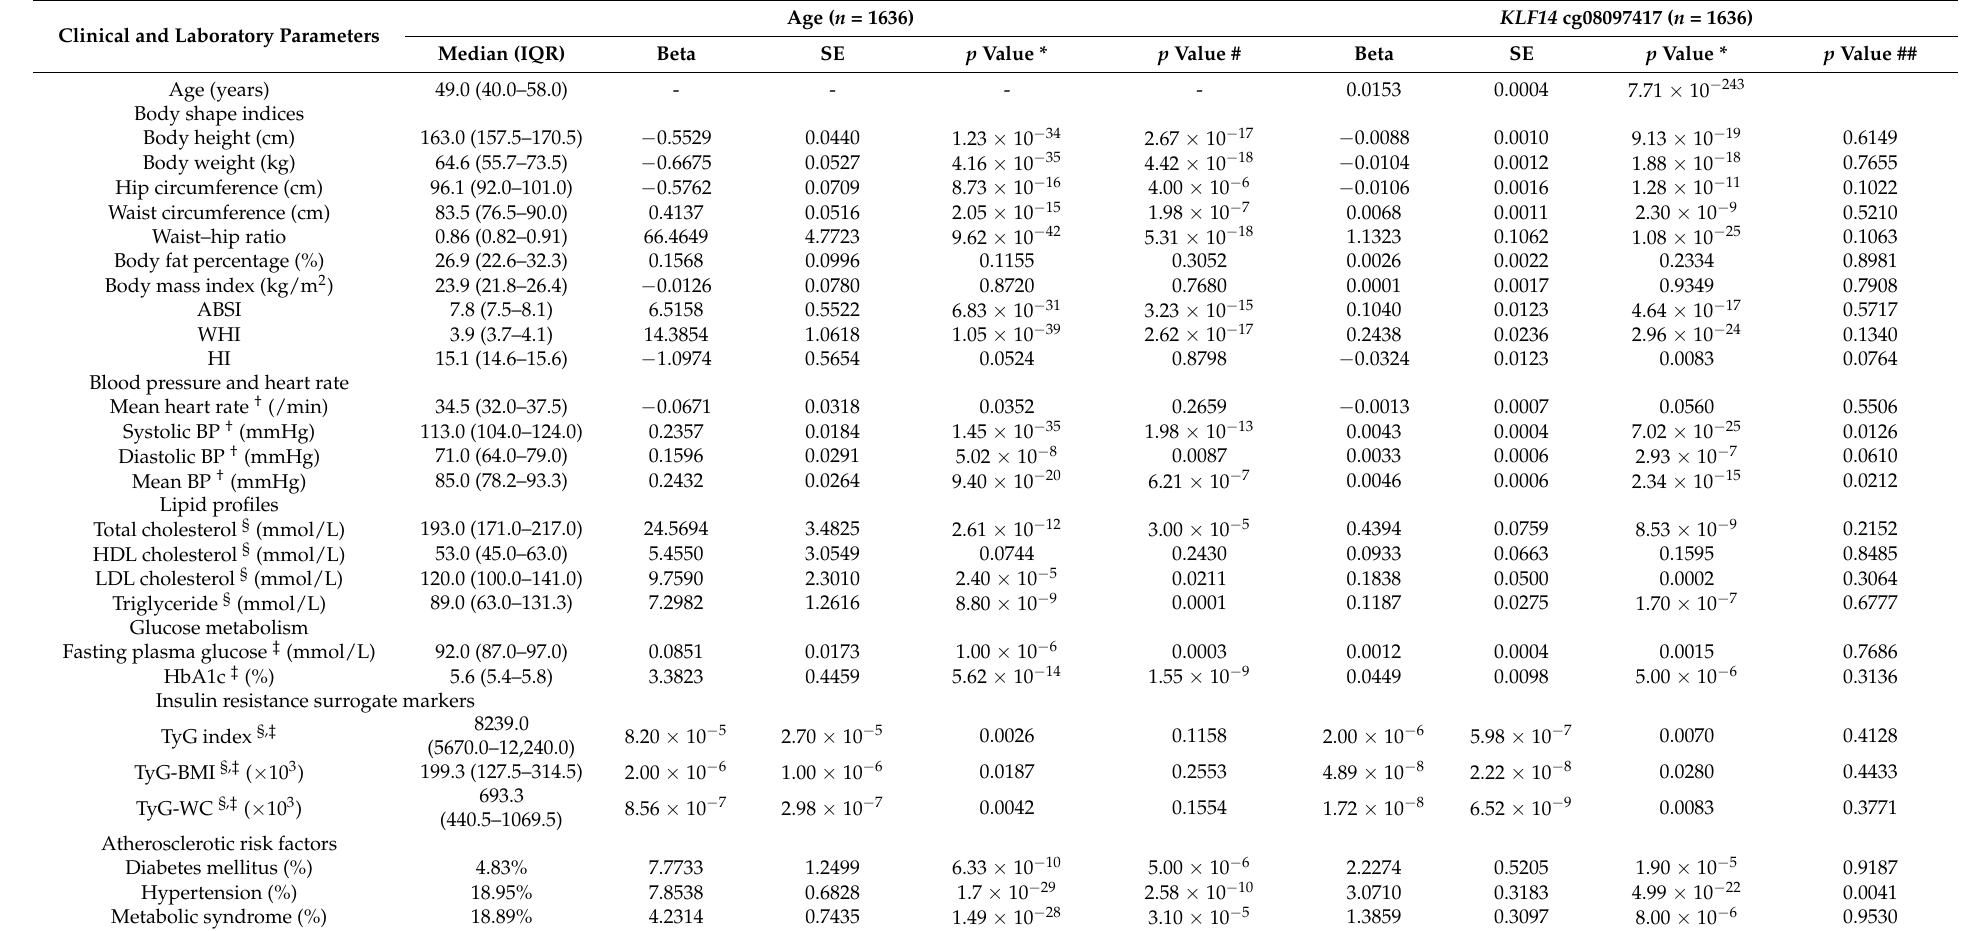
Abbreviations, adjusted condition, and subjects recruited for analysis as in Figure 1 and Table 2. * p —adjusted for age, sex, BMI, and current smoking. # p —adjusted for age, sex, BMI, current smoking, and cg08097417; ## p —adjusted for age, sex, BMI, current smoking, and age. Significance between age and studied phenotypes was defined as a p value